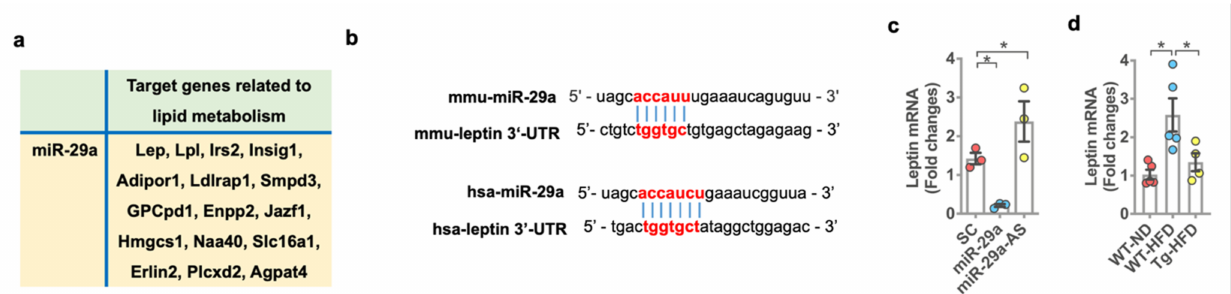
Figure 7. Effects of forced miR-29a expression or knockdown on leptin expression in mesenchymal stem cells and HFD-fed bone tissue. Bioinformatics prediction showing miR-29a targeted genes, which involved lipid or adipocyte metabolism ( a ). Sequences of 3 (cid:48) -UTR in human and murine leptin targeted by miR-29a ( b ). Gain of miR-29a function inhibited leptin expression, whereas miR-29a knockdown promoted the expression ( c ). miR-29a overexpression attenuated HFD-induced leptin expression in bone tissue ( d ). Mean ± S.E. of in vitro and in vivo models are calculated from 3 experiments and 4–5 mice, respectively. * p < 0.05 upon ANOVA test and Bonferroni post hoc test. Scramble, scrambled control; miR-29a, miR-29a mimics; miR-29a-AS, miR-29a antisense oligonucleotide; ND, standard rodent chow; HFD, high-fat